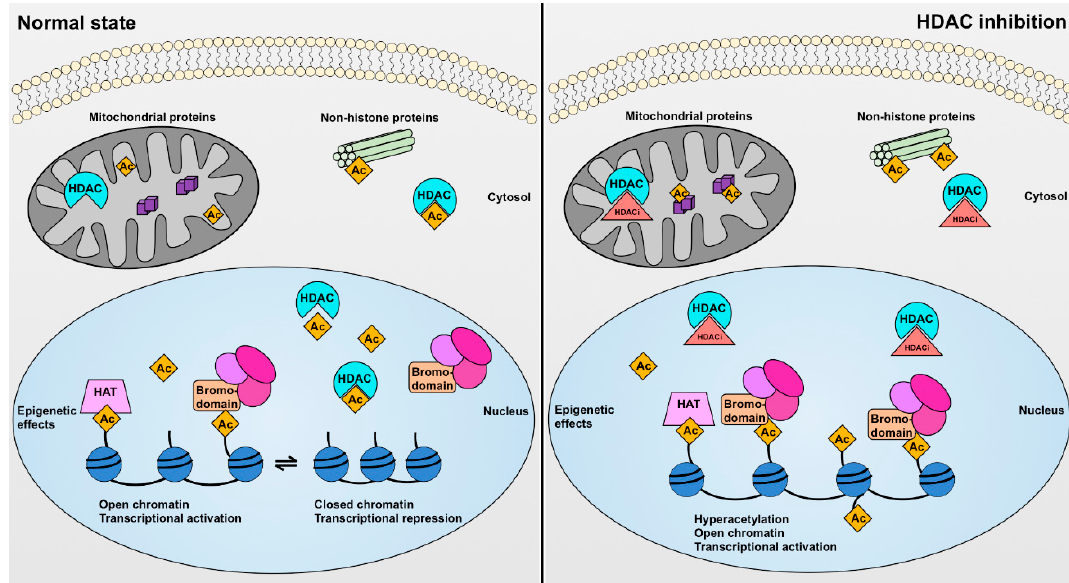
Figure 2. Cellular effects of histone deacetylases (HDACs) and HDAC inhibitors (HDACis). In the normal state (left) HDAC enzymes mediate the enzymatic removal of functional acetyl groups (Ac) from lysine residues on histone and non-histone proteins. In the nucleus, histone protein acetylation (regulated by histone acetyltransferase (HAT) enzymes) can epigenetically affect gene transcription by causing a more open chromatin configuration permitting access by the transcriptional machinery and by serving as a recognition point for bromodomains possessed by transcriptional regulatory complexes, whereas histone deacetylation has the opposite effect. Some HDAC enzymes also have effects on non-histone proteins. For instance, SIRT3, SIRT4, and SIRT5 are mitochondrial proteins, whereas HDAC6 is localized primarily in the cytosol where it deacetylates proteins including α -tubulin. Pharmacological HDAC inhibition (right) can increase the acetylation of both histone and non-histone proteins resulting in both epigenetic and non-epigenetic effects on cell function.